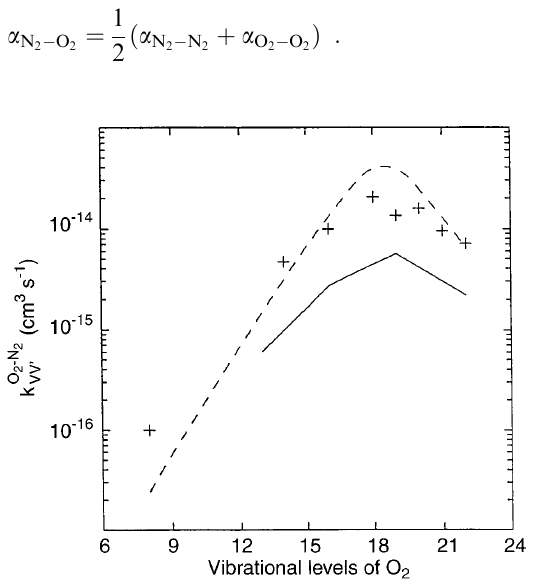
Fig. 4. The dependence of the sum of rate coe(cid:129)cients for the VV- processes O 2 (cid:133) n (cid:134) (cid:135) O 2 (cid:133) 0 (cid:134) ! O 2 (cid:133) n (cid:255) 1 (cid:134) (cid:135) O 2 (cid:133) 1 (cid:134) and for the VT- processes O 2 (cid:133) n (cid:134) (cid:135) O 2 (cid:133) 0 (cid:134) ! O 2 (cid:133) n (cid:255) 1 (cid:134) (cid:135) O 2 (cid:133) 0 (cid:134) on vibrational level n : dashed line , our calculation: solid line , semiclassical trajectory calculation of Billing and Kolesnick (1992): crosses , experimental data of Park and Slanger (1994)